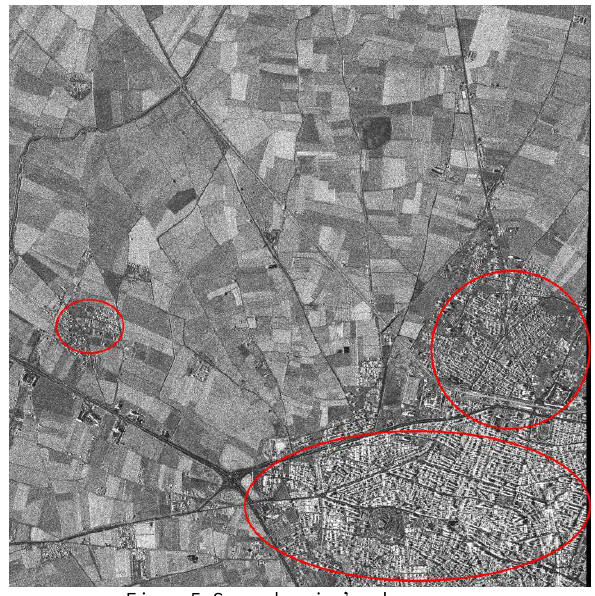
Figure 5. Second region’s urban areas